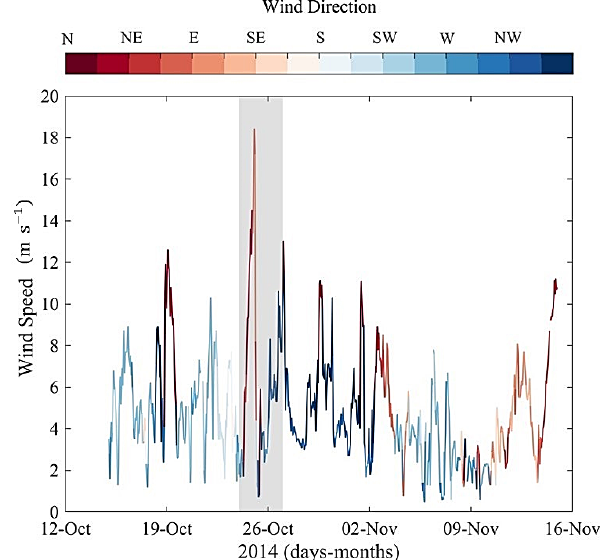
Figure 7. Wind speeds and directions at ˙I˘gneada for the October 2014 event. Shaded area highlights the CTW excitation